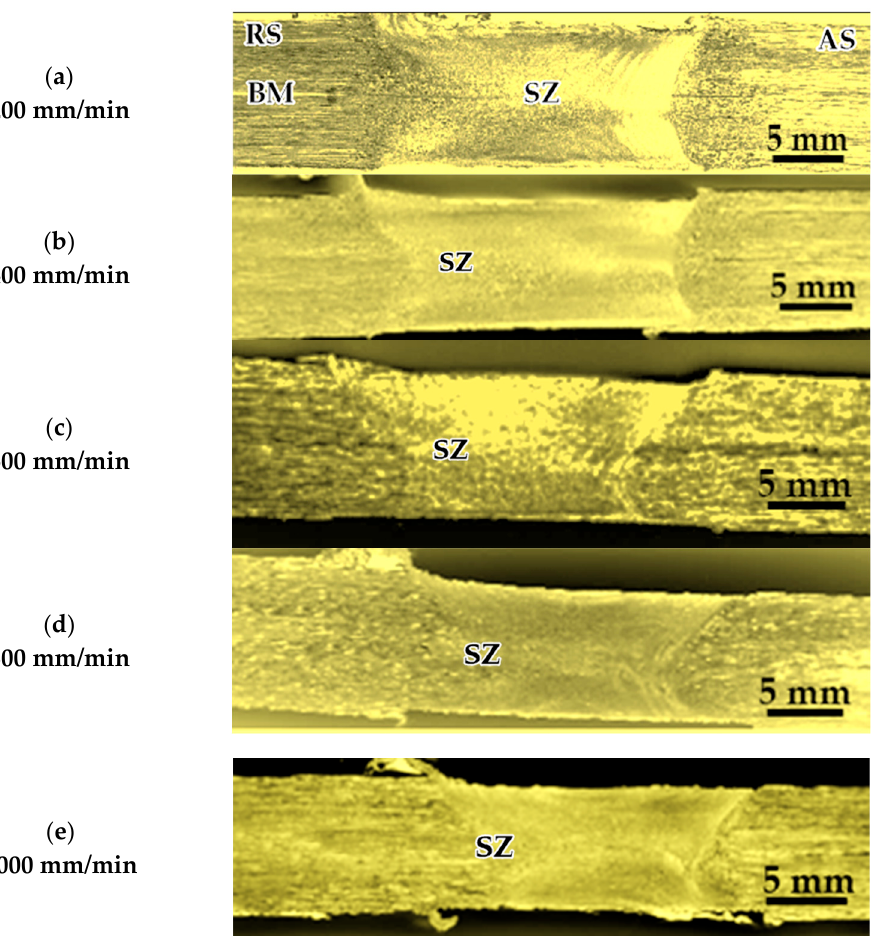
Figure 17. Macrographs of transverse cross-sections of lap joints produced at 600 rpm rotation speed and different travel speeds of ( a ) 200, ( b ) 400, ( c ) 600, ( d ) 800, and ( e ) 1000 using BT with Cy pin.